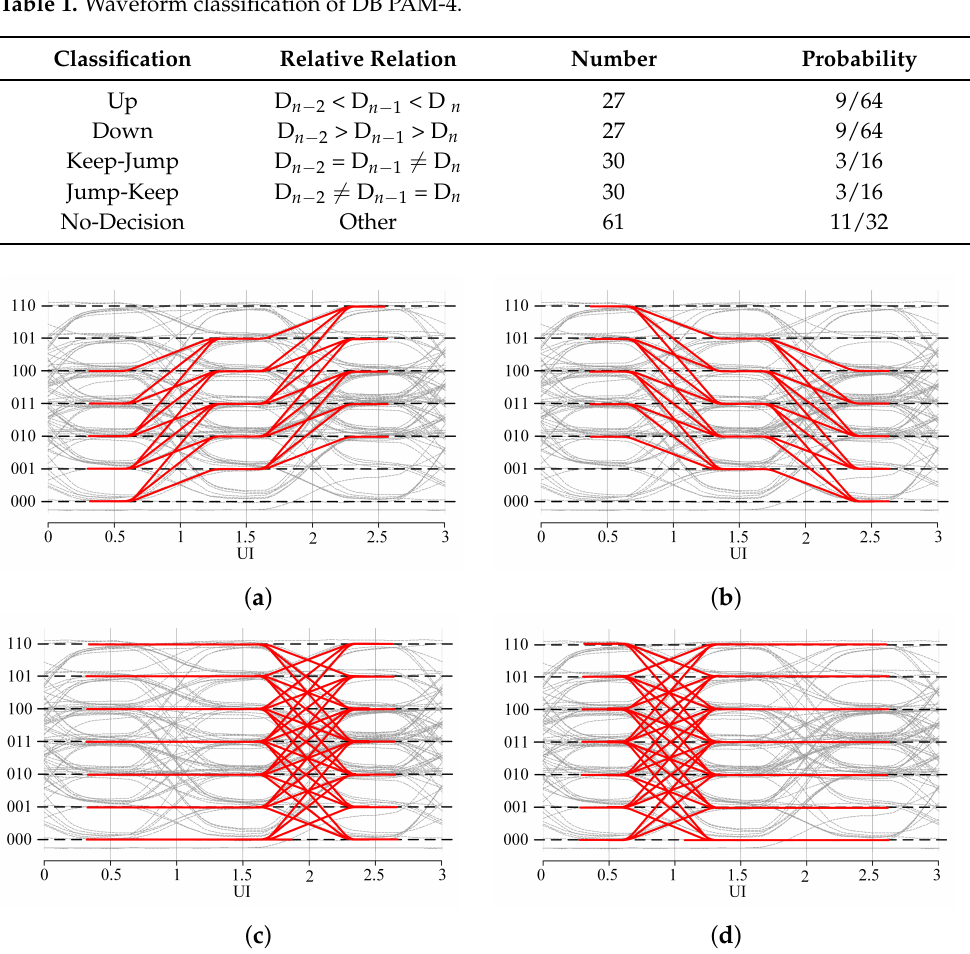
Figure 5. Waveform classification of DB PAM-4, ( a ) Up, ( b ) Down, ( c ) Keep-Jump, and ( d )